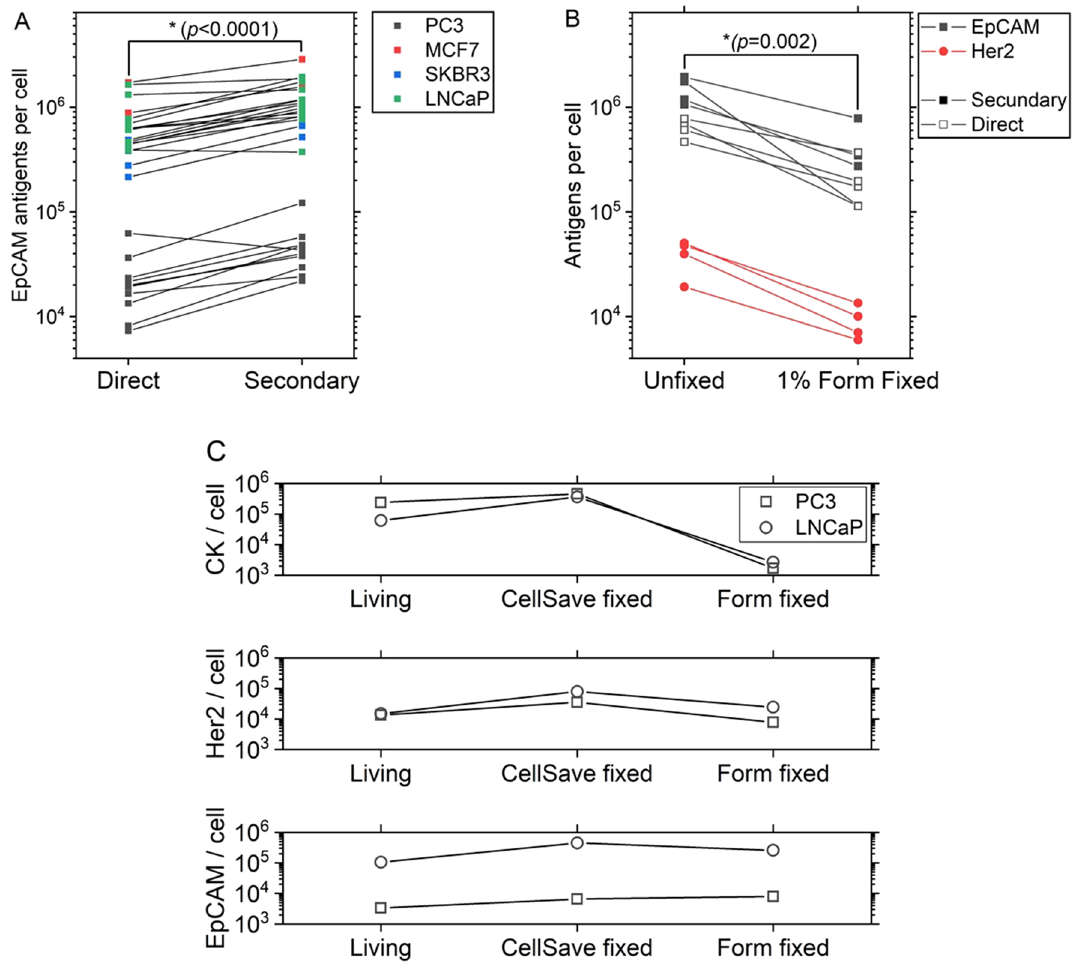
Figure 1. ( A ) EpCAM expression of unfixed PC3 (N = 11), MCF7 (N = 4), SKBR3 (N = 4) and LNCaP (N = 11) measured either using a directly conjugated antibody or by secondary antibody staining. ( B ) EpCAM and Her2 expression of LNCaP cells measured using unfixed or 1% formaldehyde fixed cells (N = 3). ( C ) CK, Her2 and EpCAM expression measured of unfixed, CellSave fixed and 1% formaldehyde fixed LNCaP and PC3 cells after 24 h (N = 1).